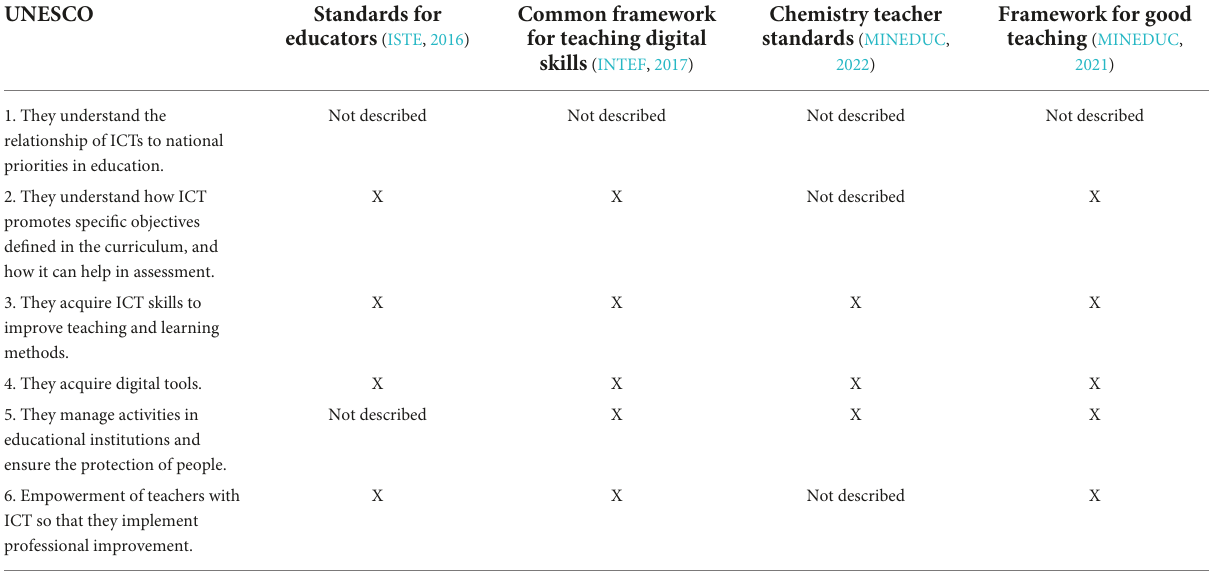
TABLE 4 Relationship between UNESCO and teacher training frameworks in Chile.